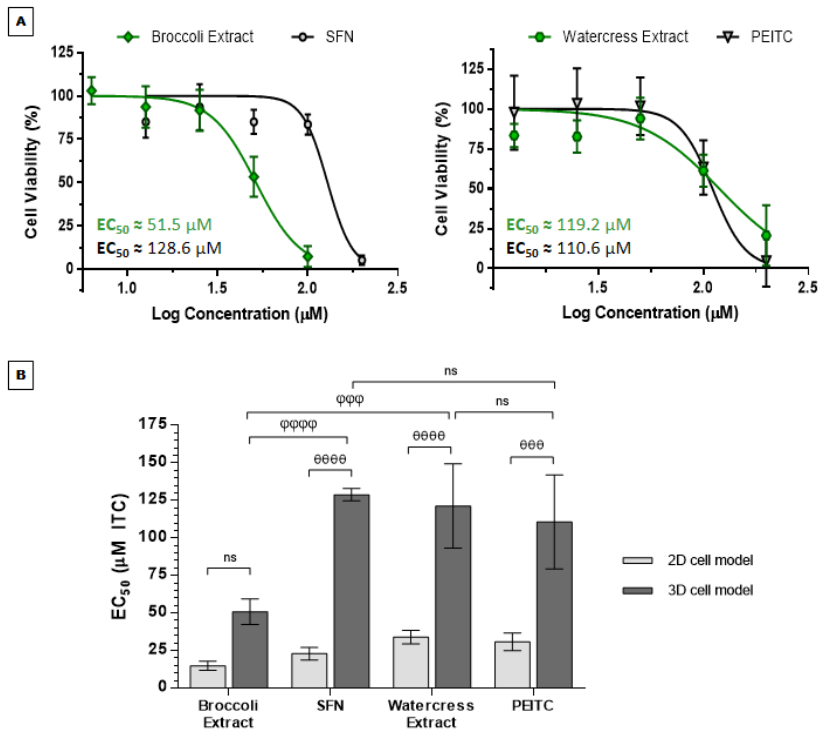
Figure 3. Treatment with natural Brassicaceae extracts and ITCs impair cell proliferation in HT29 spheroids after exposition for 24 h. ( A ) Dose-response curves of the antiproliferative effect induced by broccoli and watercress extracts and their main ITCs, SFN and PEITC (left and right panel, respectively). Green: Brassicaceae extracts; black: ITCs; ( B ) EC 50 values of the antiproliferative response induced by Brassicaceae extracts and ITCs (presented in µ M of ITC) in HT29 monolayers (2D cell model, light grey) and HT29 spheroids (3D cell model, dark grey). Results shown are means of at least 3 independent experiments performed in triplicate ± SD, and a p < 0.05 was considered as statistically significant. θθθ p < 0.001 and θθθθ p < 0.0001 are relative to the same extract/ITC between both cell models; ϕϕϕ p < 0.001 and ϕϕϕϕ p < 0.0001 are relative to broccoli extract.